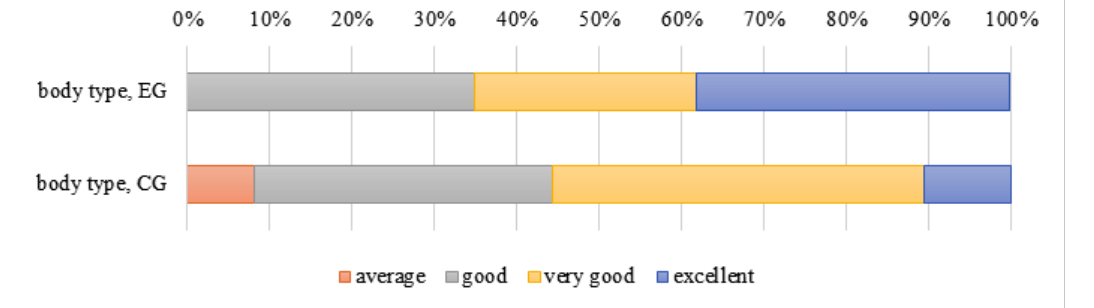
Fig. 4. Intragroup distribution of females of experimental (EG) and control (CG) groups by a body type at the end